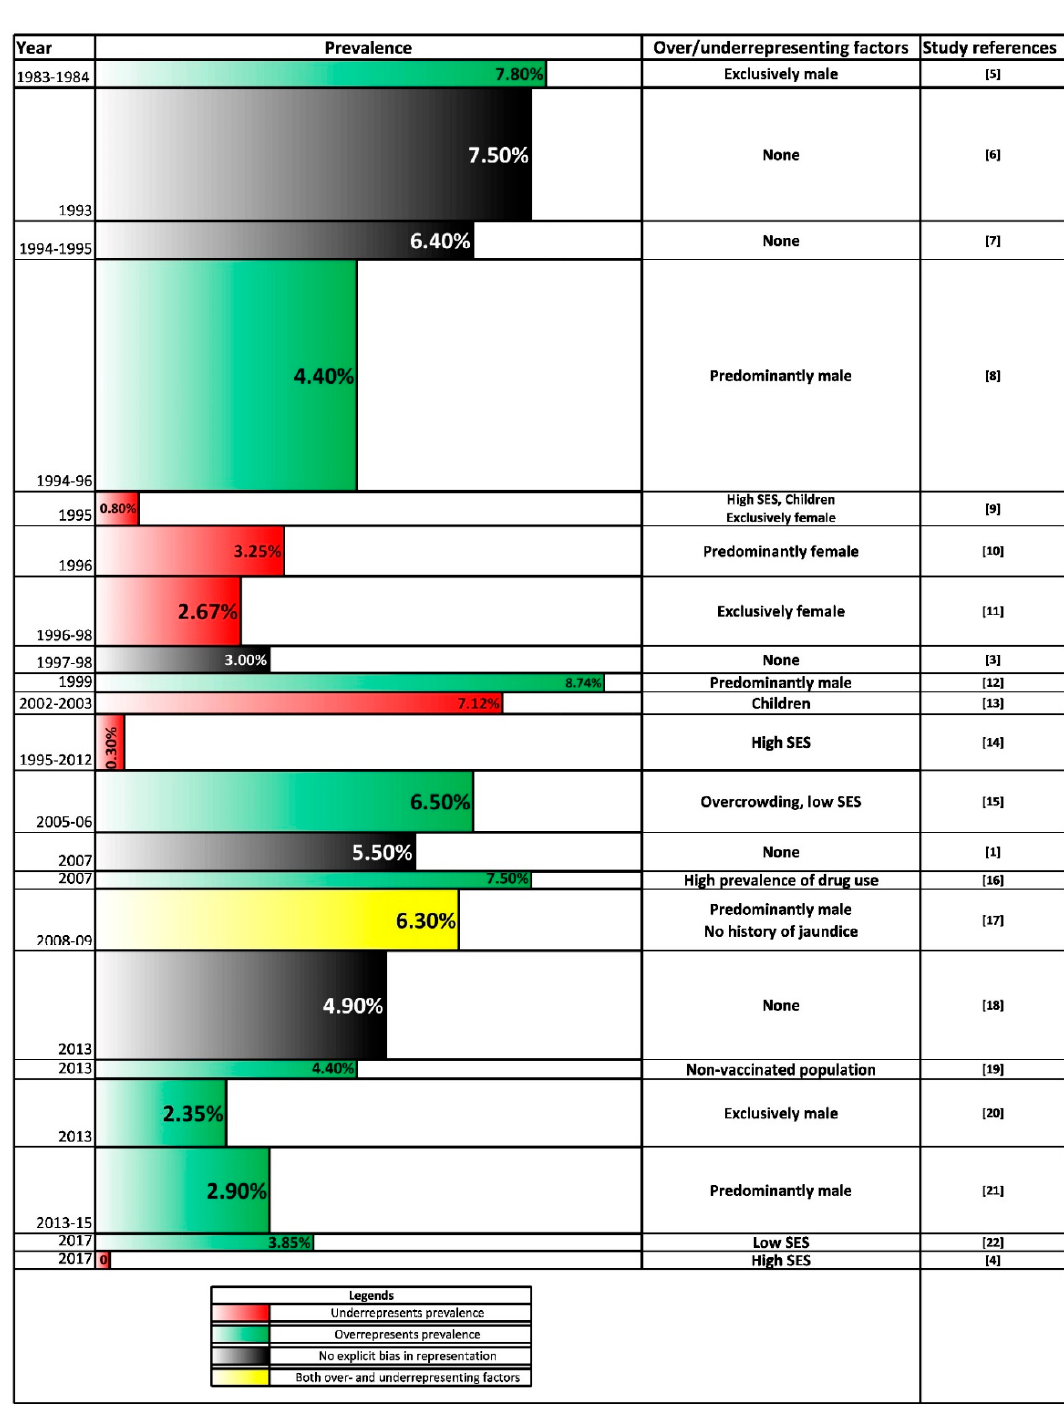
Figure 1. Studies reporting the prevalence of hepatitis B surface antigen among otherwise healthy populations in Bangladesh. The bar heights are factors of the normalized sample sizes of each study. The sample sizes ranged from 130 [3–22] to 43,312 [8]. Studies done on voluntary blood donors and pregnant women have not been included here, since they form a substantial enough group to merit their own discussion.